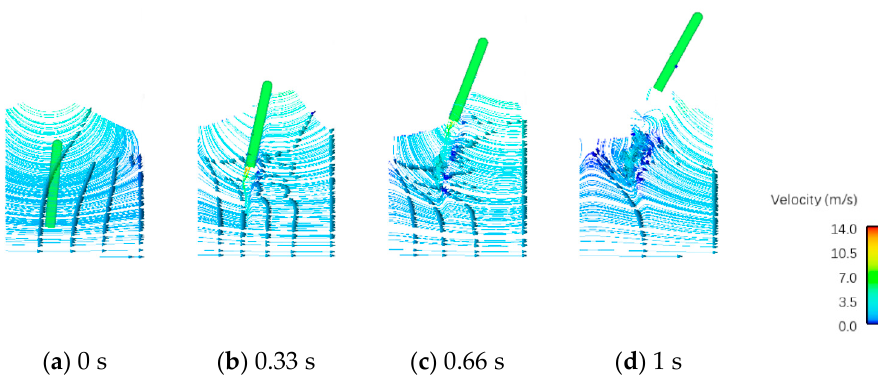
Figure 19. Images of pitch angle variation of vehicles under di ff erent initial velocities. ( a ) Pitch angle of vehicle in case 1, 4, 7. ( b ) Pitch angle of vehicle in case 2, 5, 8. ( c ) Pitch angle of vehicle in case 3, 6, 9. According to the streamlines of submersible aerial vehicles flying out of the water shown in Figures 20 and 21 the direction of the streamlines points to the right. A vortex exists in the rear flow field of the vehicle. The smaller the initial velocity, the longer the vehicle will fly out of the water. The size of the vortex near the tail of the vehicle with larger initial velocity is larger and the corresponding velocity of the vortex is also larger.